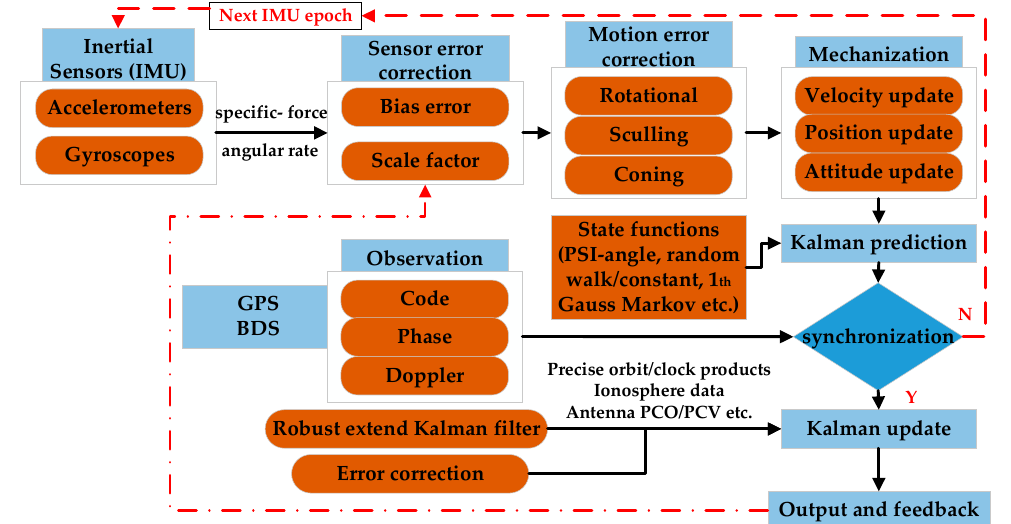
Figure 2. Algorithm structure of R-EKF aided GPS/BDS PPP/INS tight integration. R-EKF is robust extended Kalman filter, PPP is precise point positioning, INS is inertial navigation system, IMU is inertial measurement unit, and PCO/PCV is phase center offset/variation.